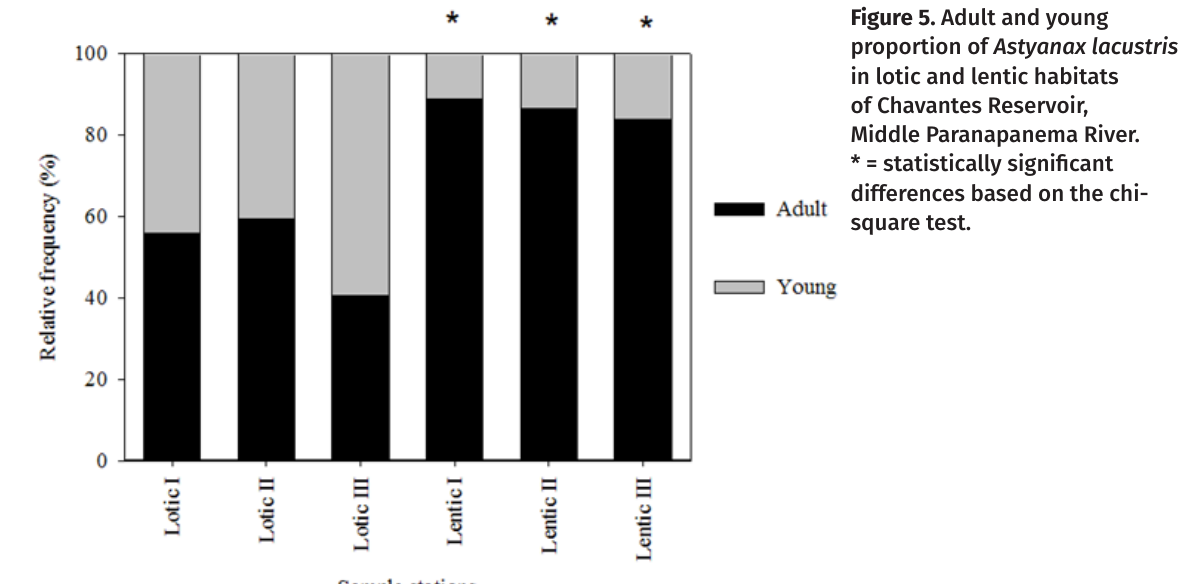
Figure 4. Slope and equations for data of length and weight of fishes in lotic and lentic habitats of Chavantes Reservoir, Middle Paranapanema River (see Table I for more details).